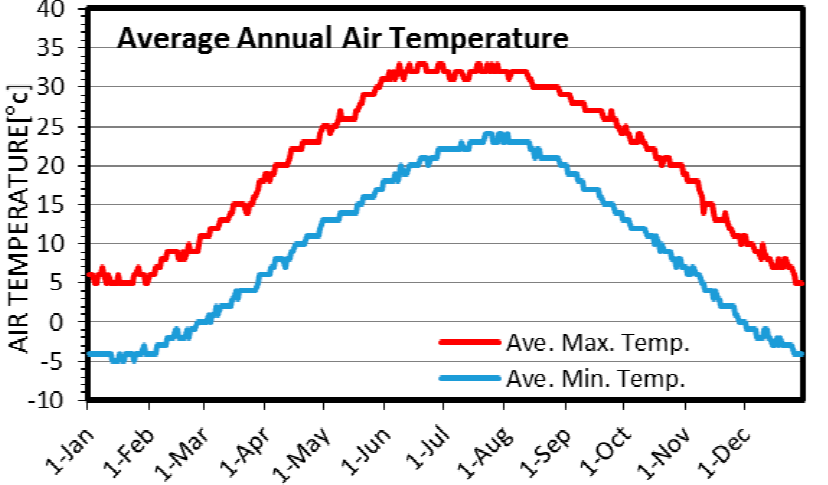
Figure 2. Average annual maximum air temperature and minimum air temperature of Zhengzhou (data source from http://www.weather.com.cn/forecast/history.shtml?areaid=101180101&month, accessed on 21 June 2021).